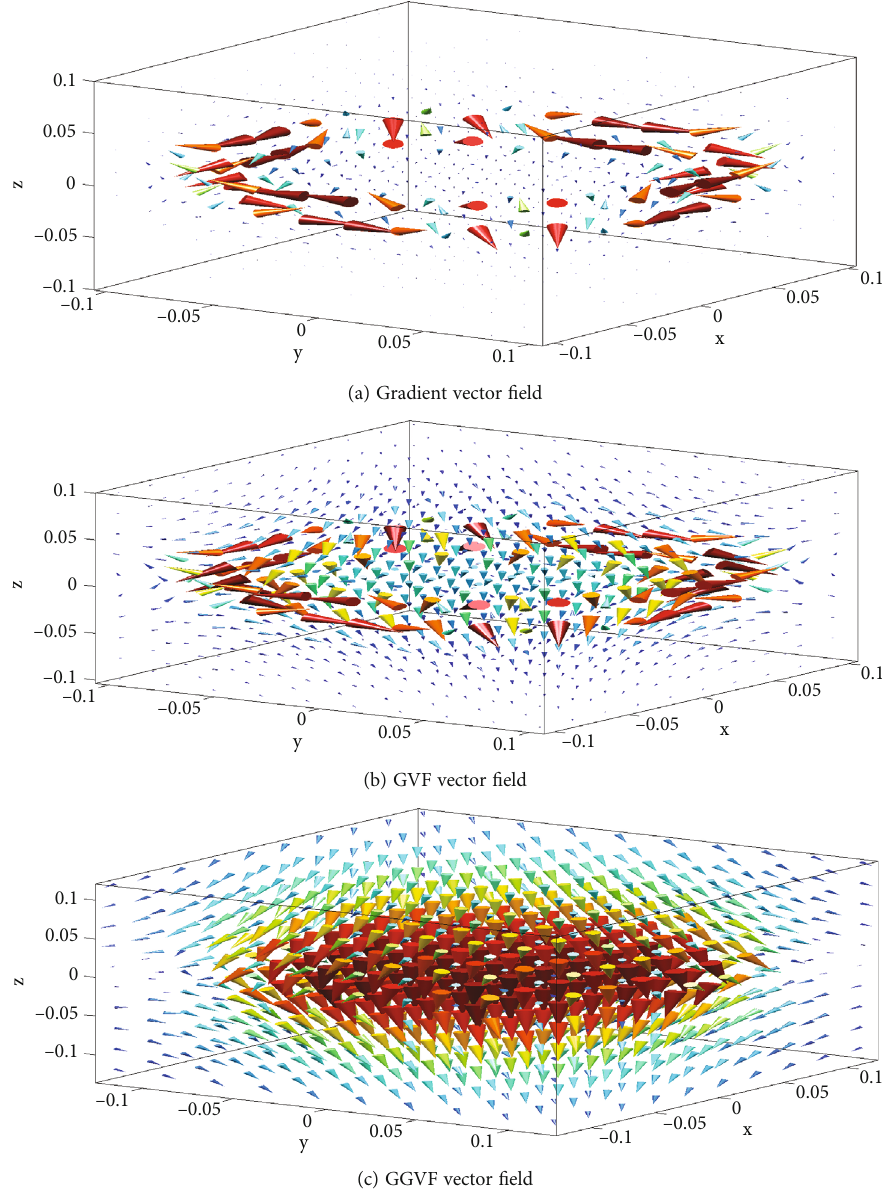
Figure 4: Comparison of vector fi elds. Table 1: Candidate basketball area